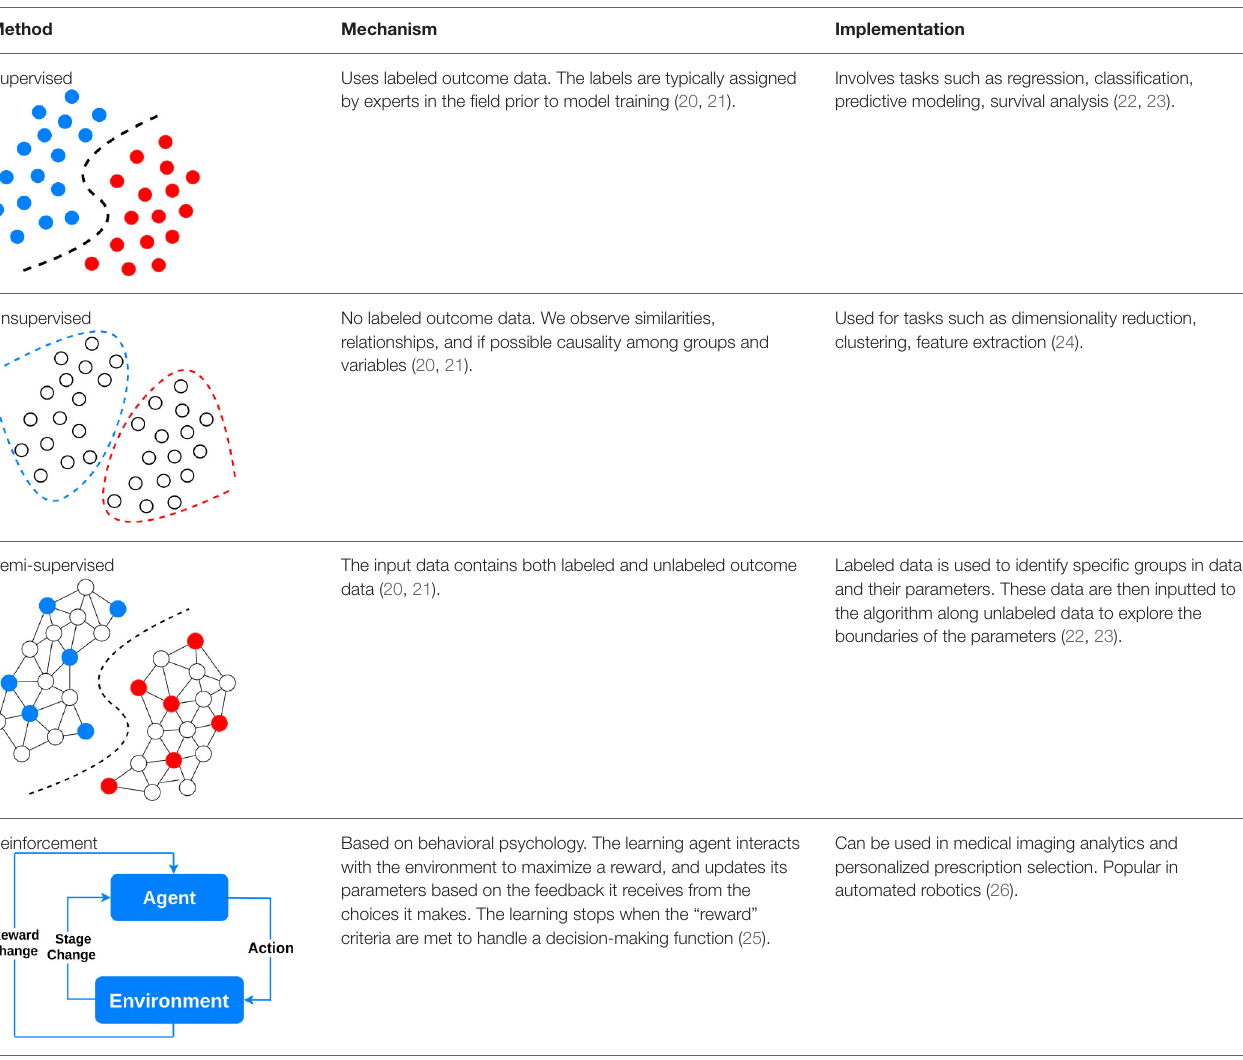
TABLE 1 | Type of learning